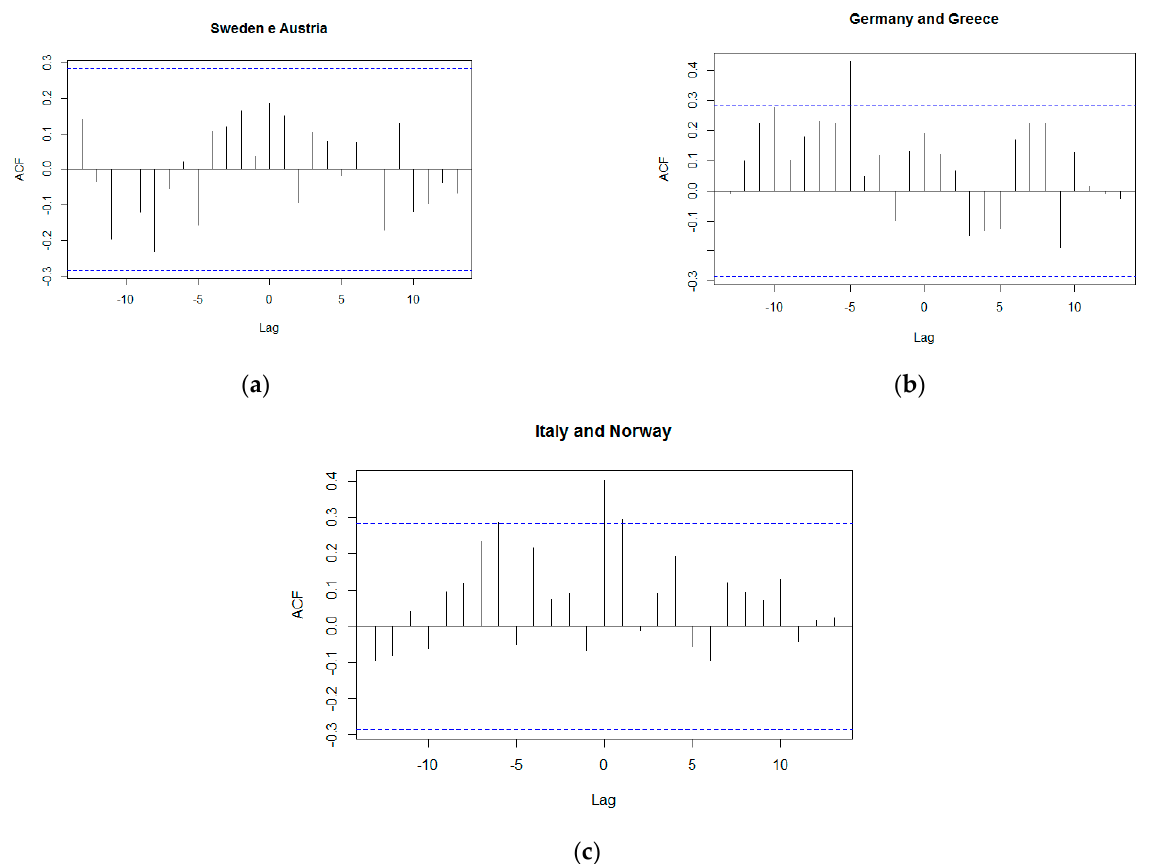
Figure 3. Cross-correlograms between Sweden and Austria, panel ( a ), Germany and Greece, panel ( b ) and Italy and Norway, panel ( c ).